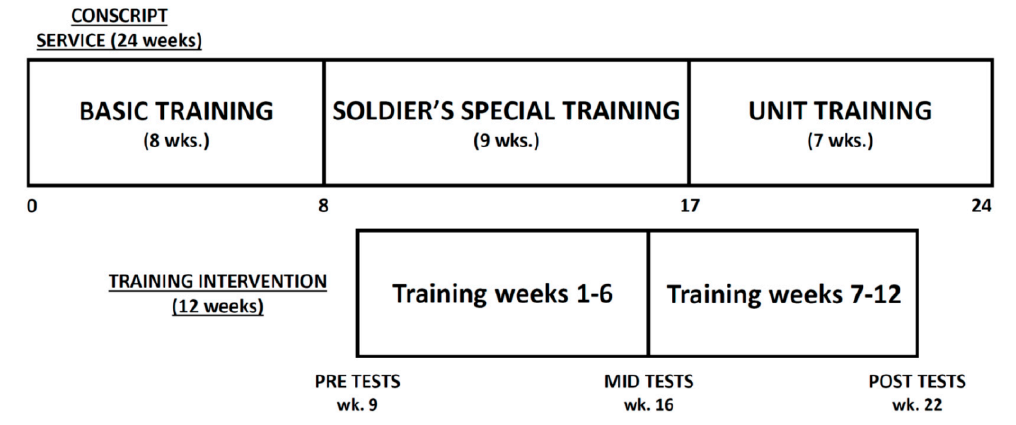
Figure 1. Timeline of the